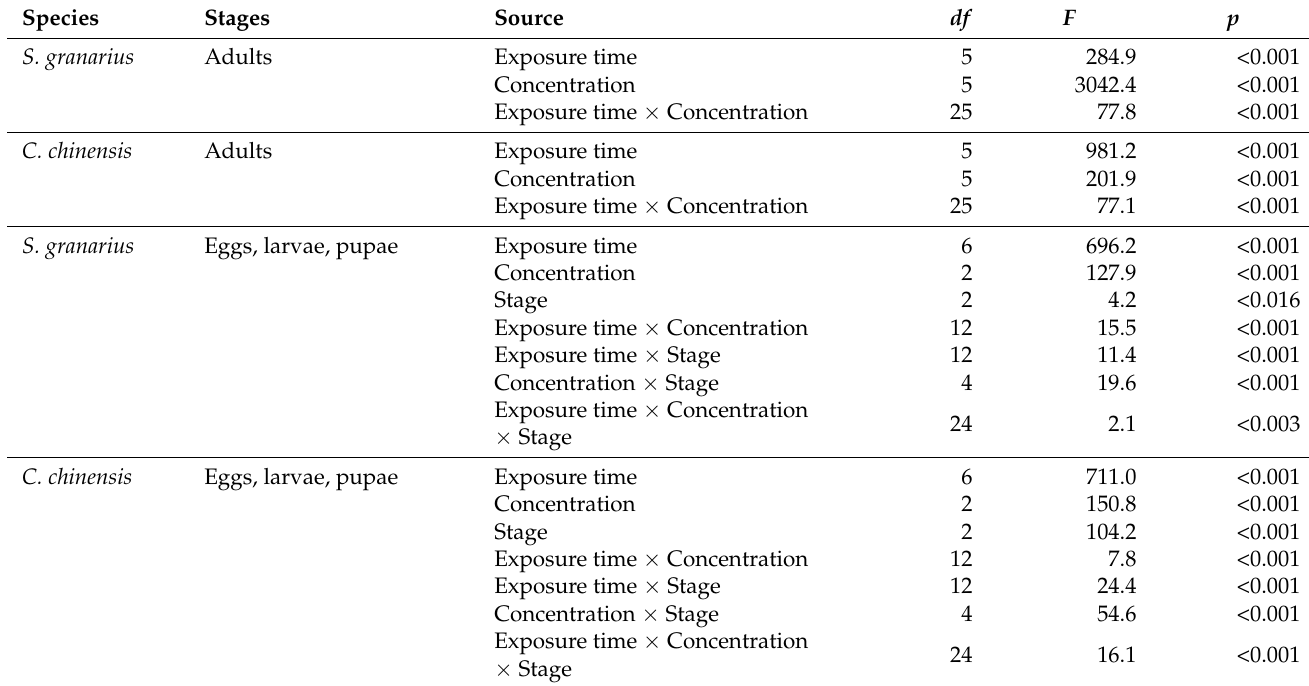
Table 1. Parameters of ANOVA for main effects related to mortality of the exposed adults of Sitophilus granarius (df = 180) and Callosbruchus chinensis (df = 180) or to S. granarius (df = 315) and C. chinensis —(df = 315). adult emergence following their previous N 2 exposure in sub-adult stages (egg, larva and pupa).